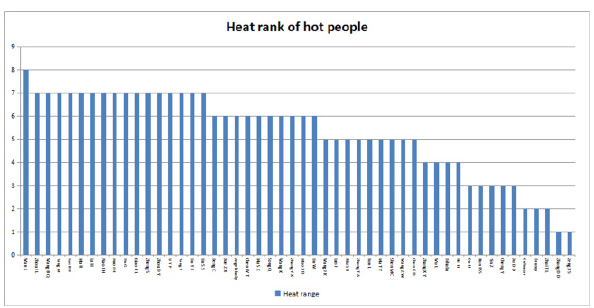
Fig. 4. Heat Rank of Hot